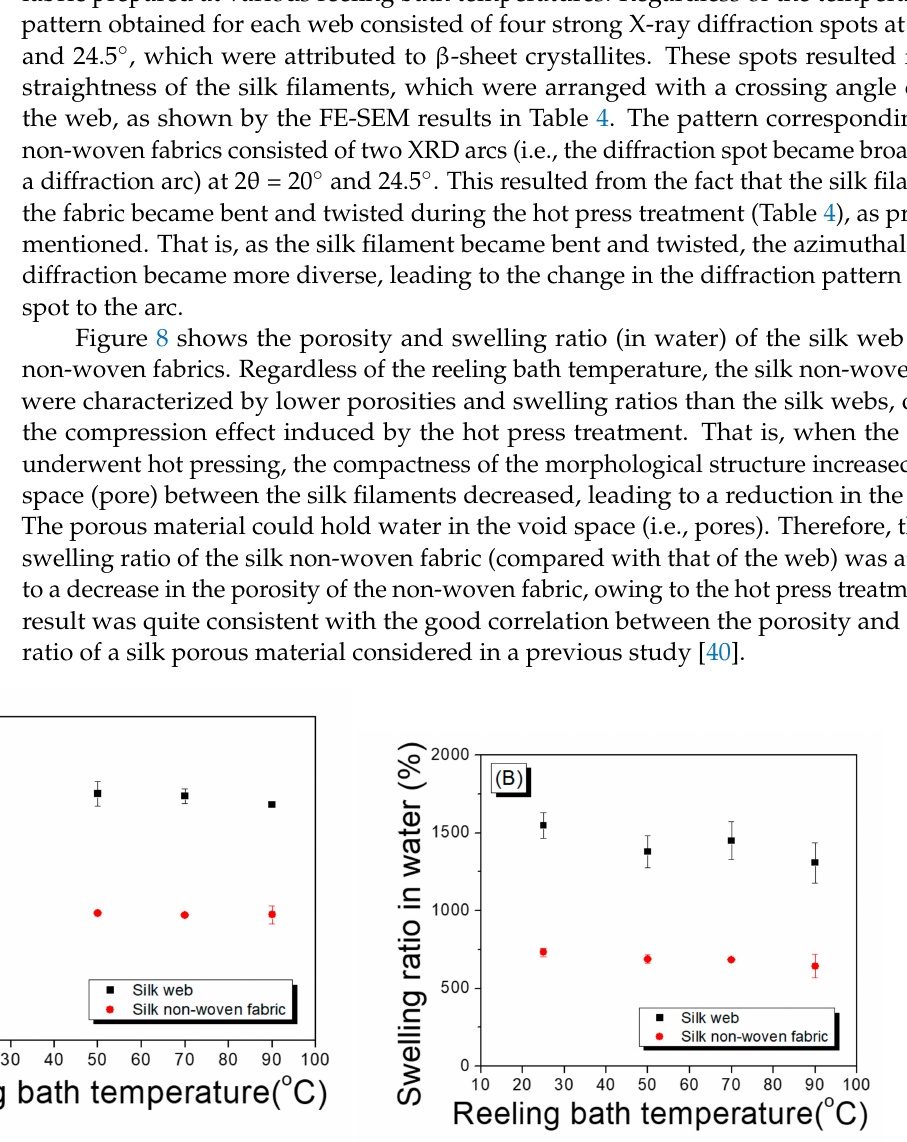
Figure 8. ( A ) Porosity and ( B ) swelling ratio of silk web and silk non-woven fabrics prepared at various reeling bath temperatures. The reeling velocity was 39.2